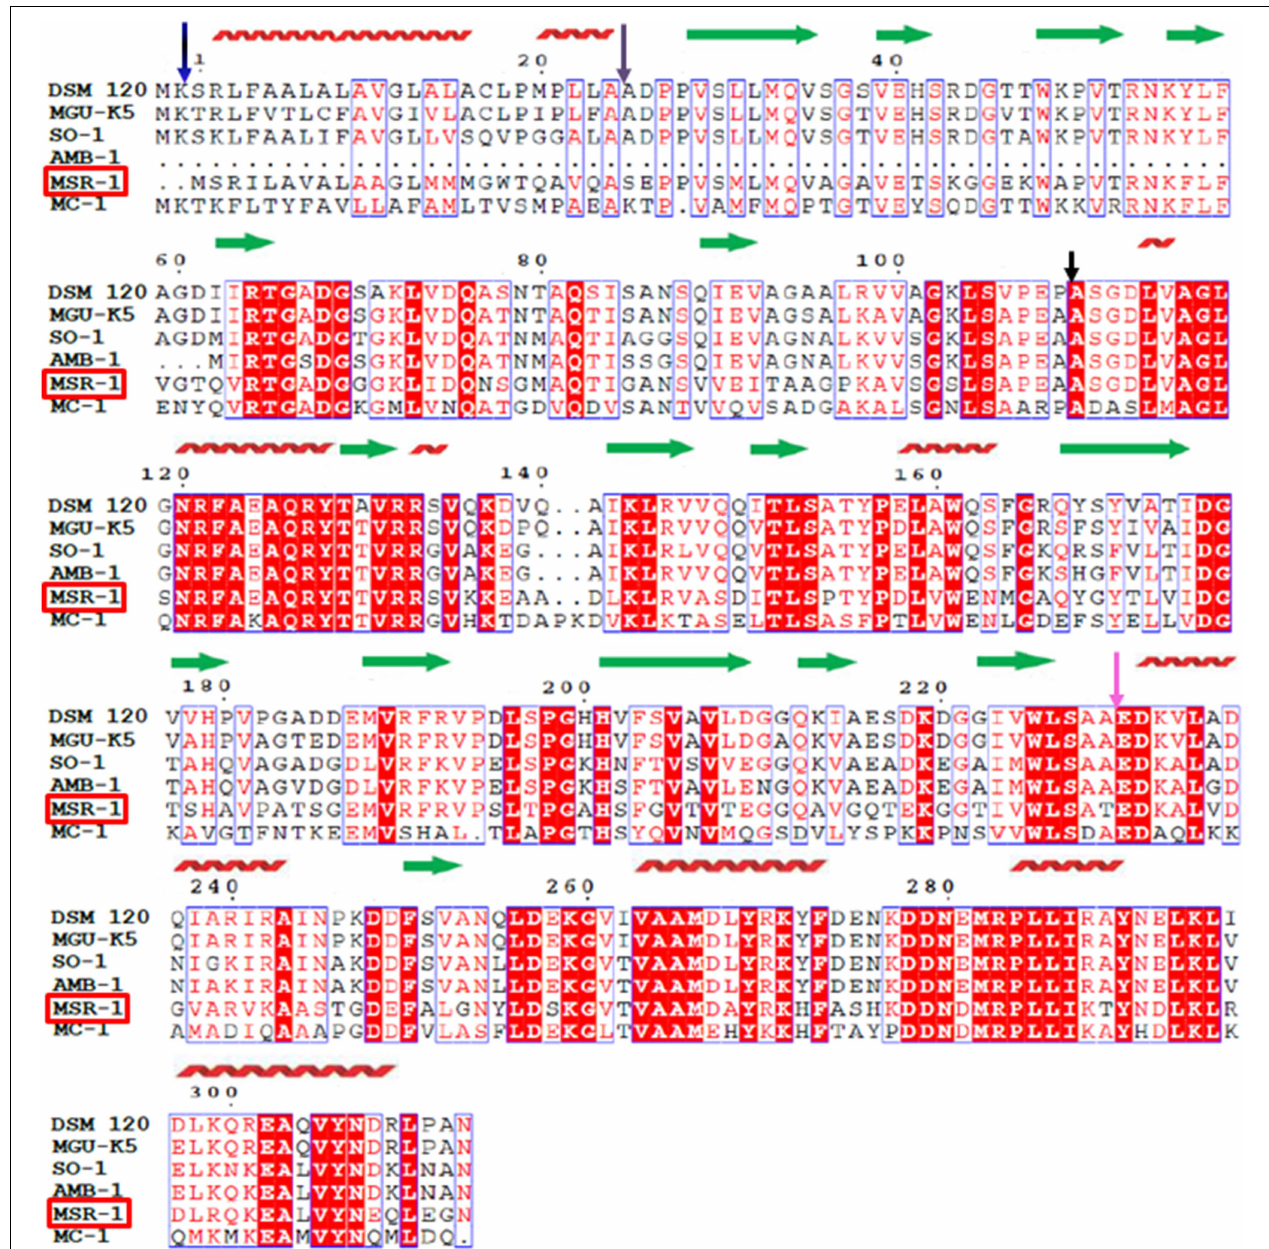
magneticum AMB-1 amb2230 (AMB-1) and the Magnetococcus sp. MC-1 Mmc1_3696 (MC-1). Strictly conserved residues are highlighted with a red background and highly homologous residues are boxed. The secondary structural elements of MSR-1 defined by the analysis of the structure by using the PSIPRED server are indicated as red coils for α -helices and green arrows for β -strands. The purple arrow indicates for the end of the signal peptide.